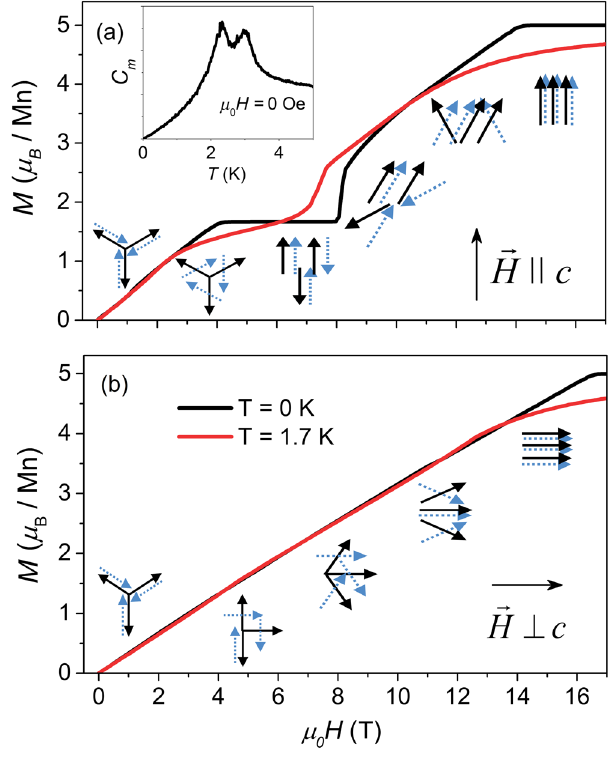
⃗ H k c ⃗ H ⊥ c FIG. 17. Calculated magnetization curves for (a) and (b) from a triangular magnetic lattice characterized by the NN exchange interaction and easy-axis anisotropy determined ex- perimentally. Temperature effect on the magnetization plateau is shown by comparing the T ¼ 0 K (black curve) with T ¼ 1 . 7 K (red curve) calculations. The inset shows the computed zero-field heat-capacity curve that reproduces well the observed successive transitions 2.2 and 3 K. Predicted field-induced bilayer spin states from our classical Monte Carlo simulations are sketched along the magnetization curves, with the planar ac structures of the adjacent layers plotted on top of each